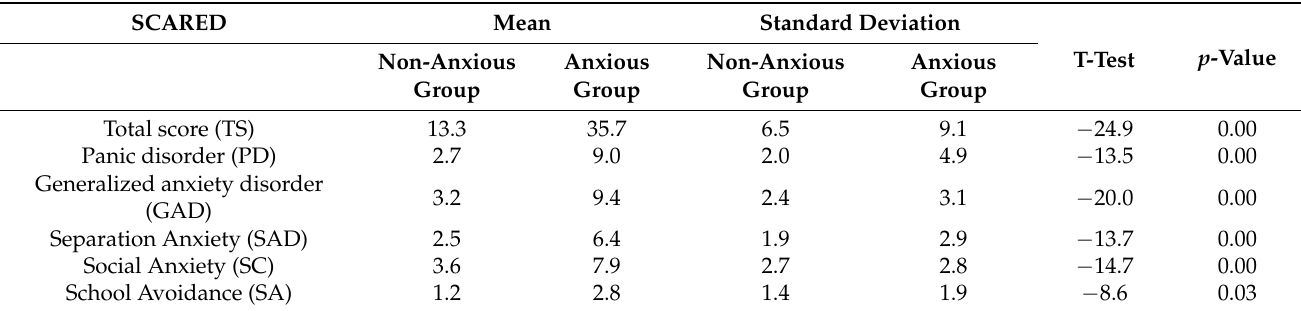
Table 2. Means, standard deviations, and t-tests for anxious and non-anxious children according to Romanian version of